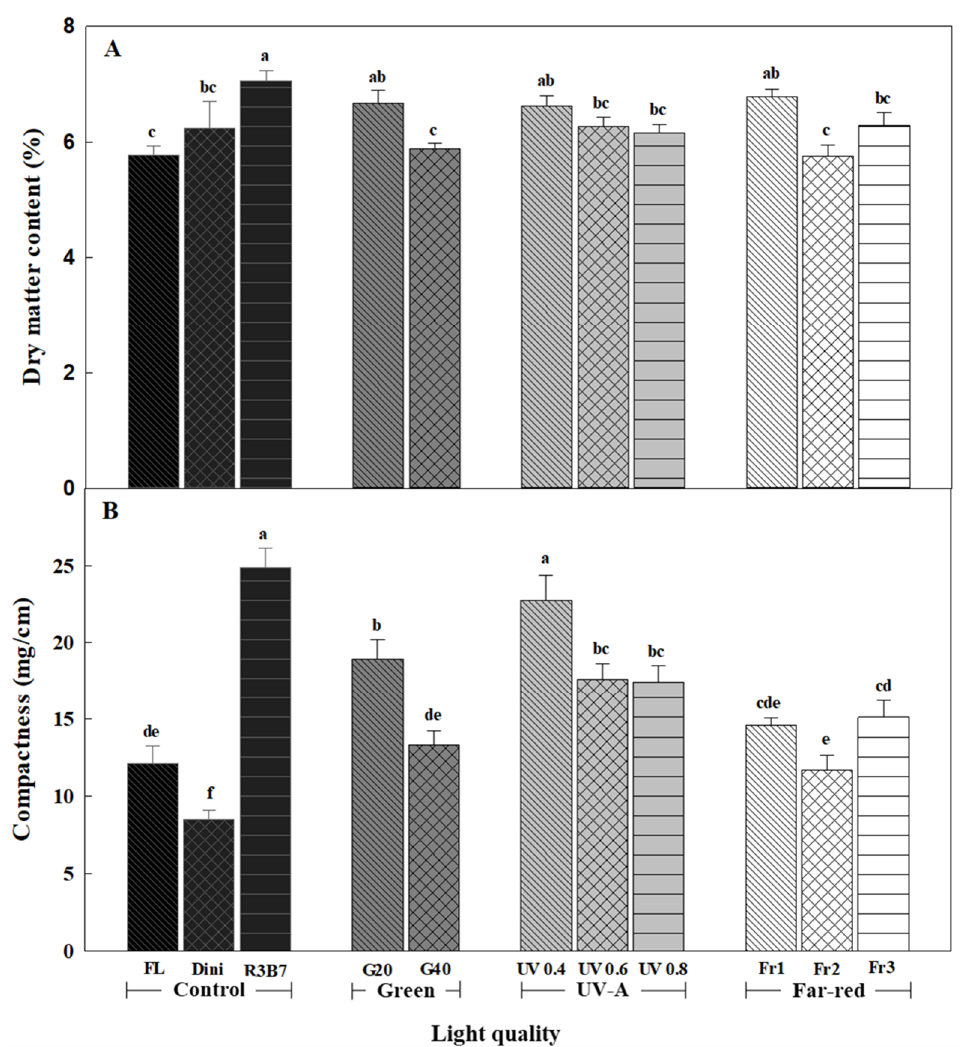
Figure 7. The effects of the light quality on the dry matter content ( A ) and compactness ( B ) of ‘Mini Chal’ tomato ( Solanum lycopersicum L.) measured 21 days after start of treatment. Refer to Figure 1 for details on the light quality. Vertical bars indicate the mean ± SD ( n = 15). Different letters above bars indicate significant differences by Duncan’s multiple range test at p = 0.05.